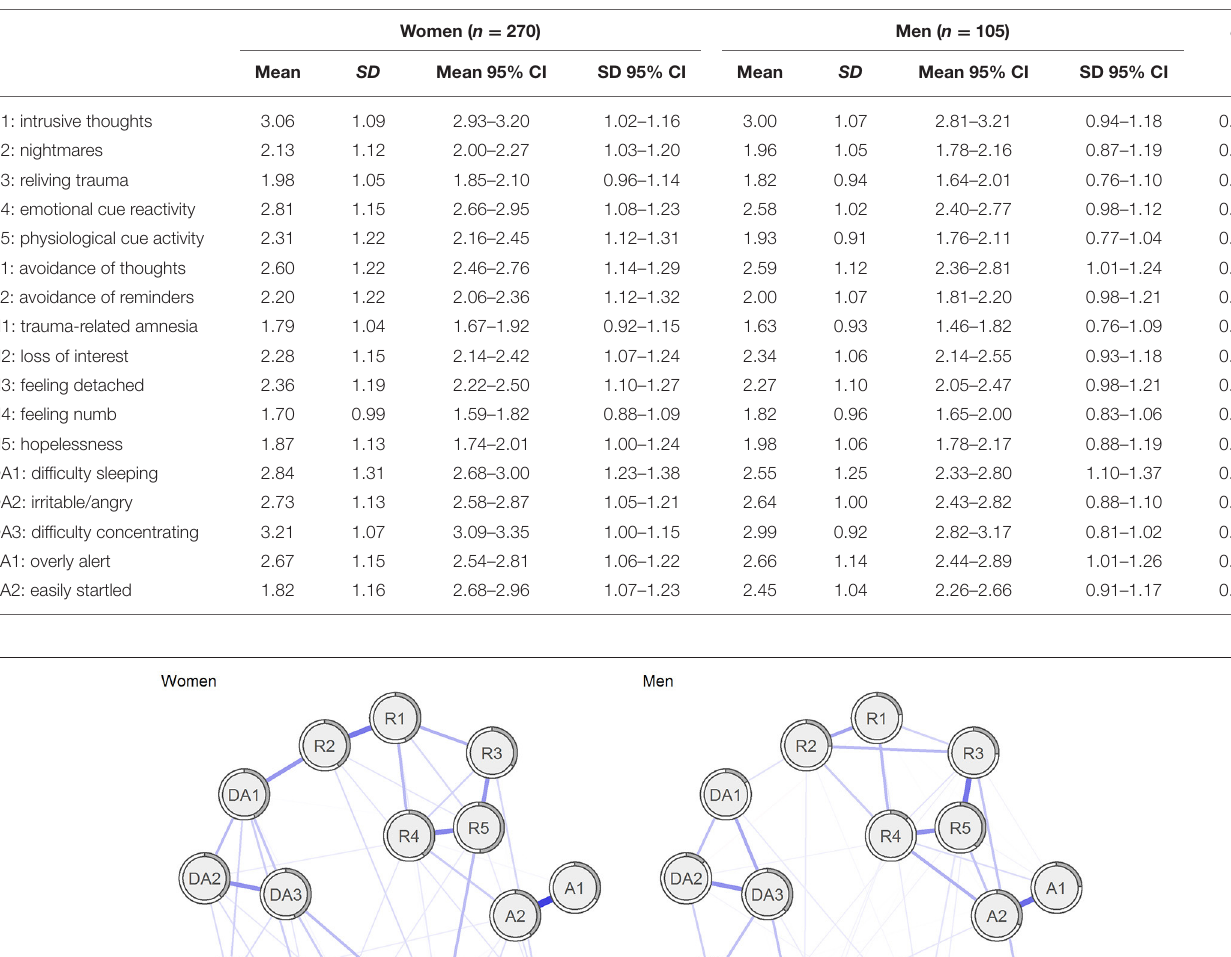
TABLE 4 | Distributions of posttraumatic symptom scores in women and men with sum of PCL ≥ 30. Women ( n = 270) Men ( n = 105)